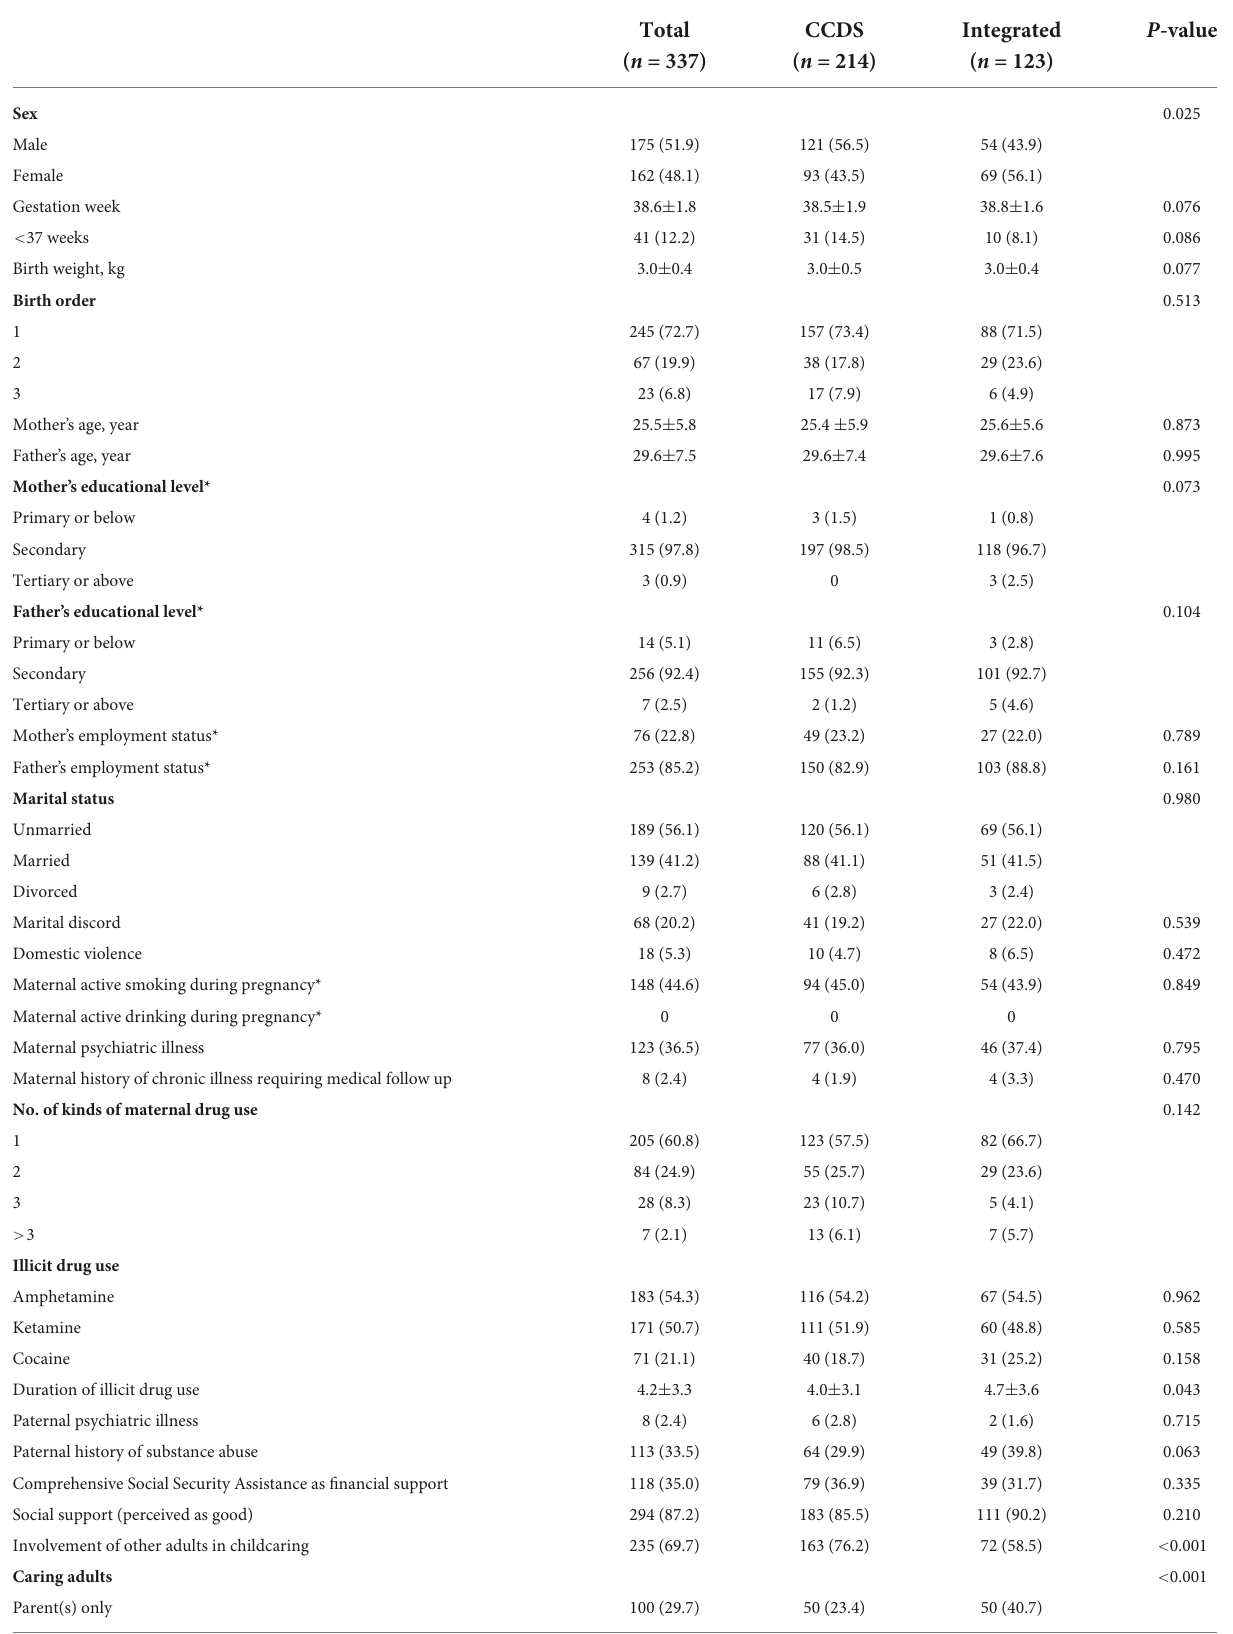
TABLE 1 Baseline characteristics ( n =